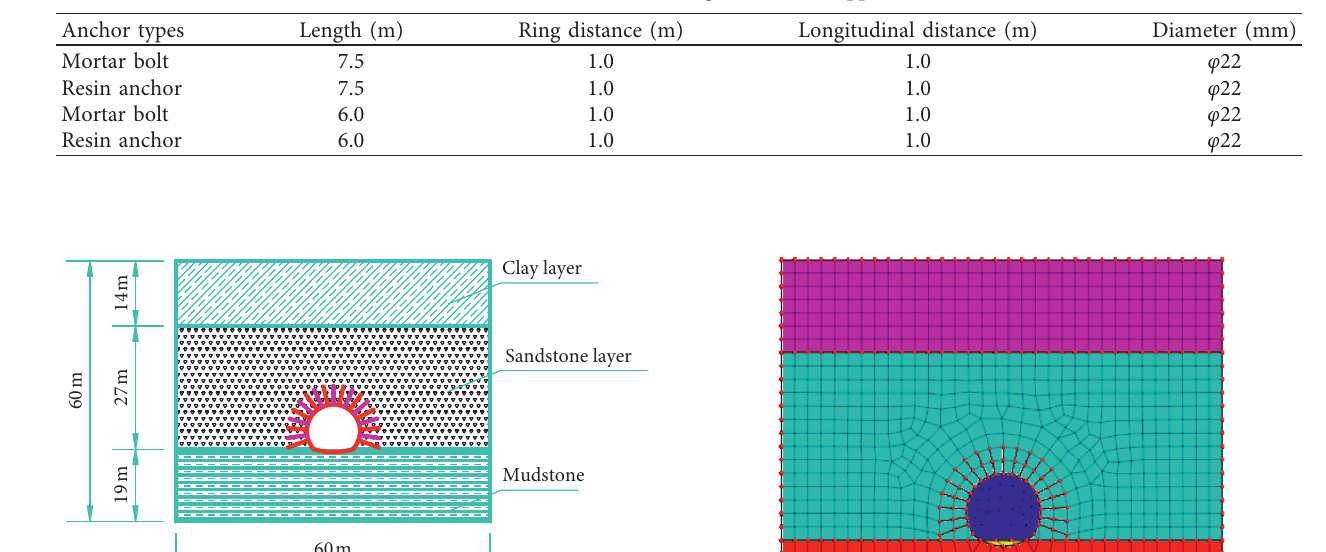
Table 5: Parameters of lengthened bolt